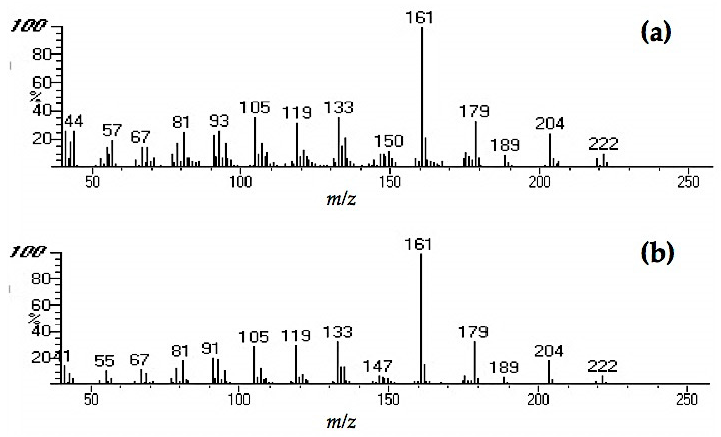
Figure 5. Mass spectra of peak 2 (retention time [RT] 27.72) from ( a ) crude decayed wood extract and ( b ) crude PDA extract.